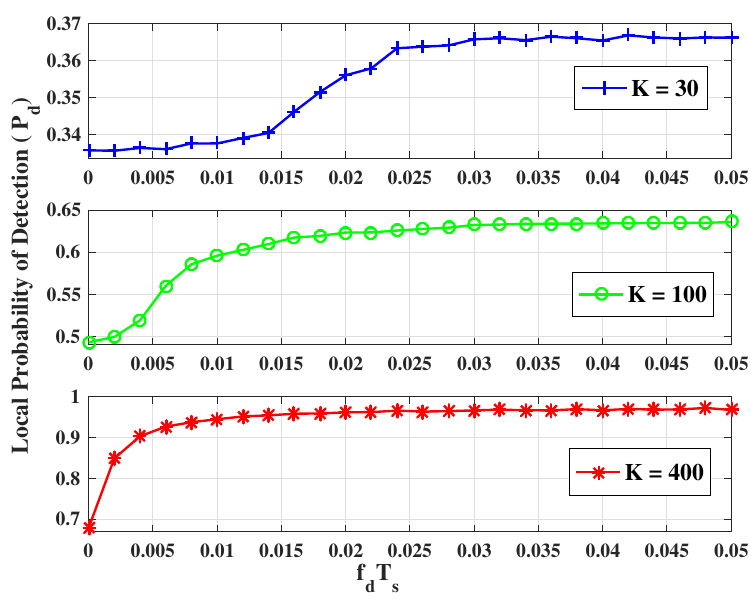
Figure 4. The detection probability of local sensing for various f d T s ( N = 1, η 0 = − 8 dB, P f = 0.1).